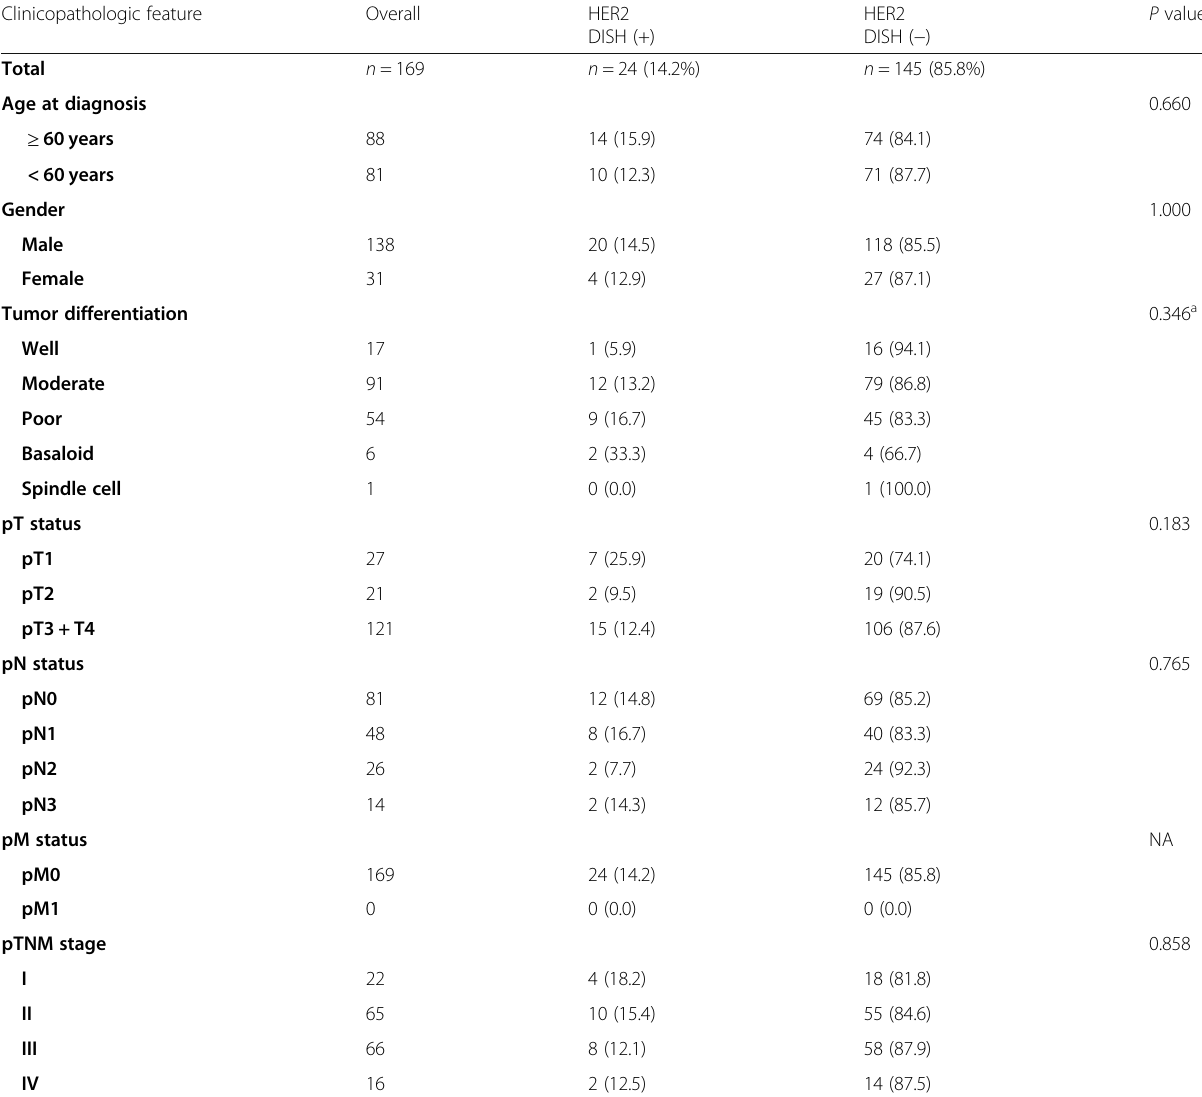
Table 2 Correlation between HER2 gene amplification status and clinicopathological parameters Clinicopathologic feature